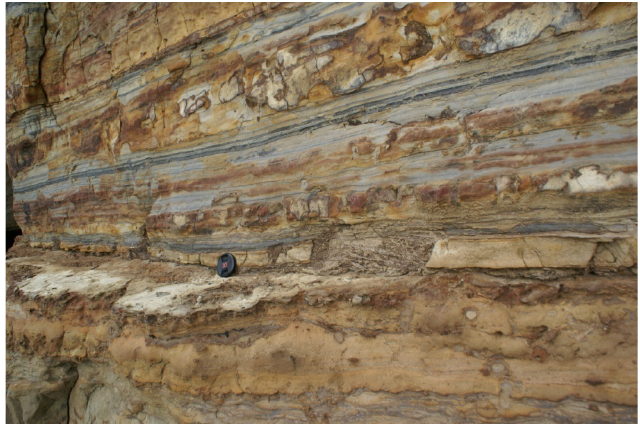
:Heterolithic facies showing flaser and lenticular bed. 4.3 Facies 1: Planar cross stratified (PcS)